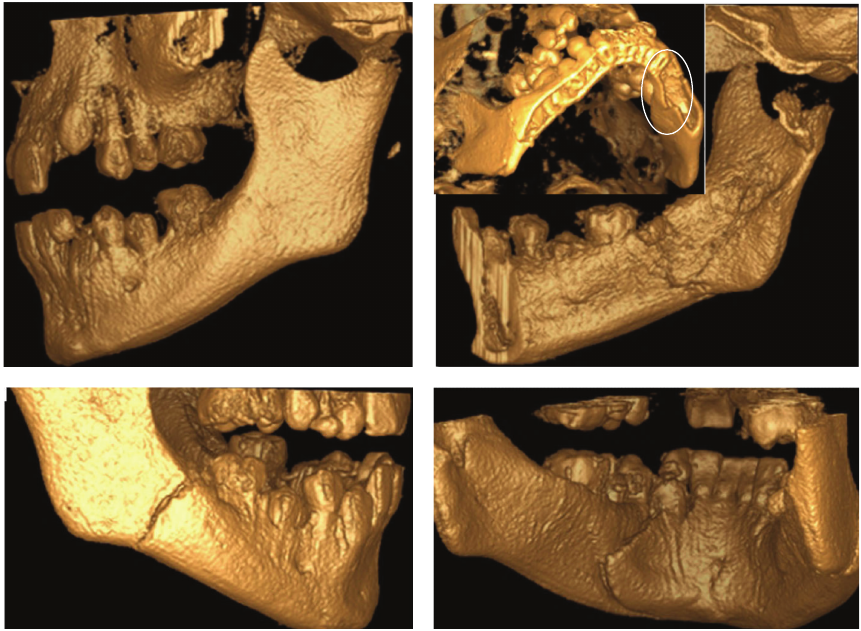
Figure 2: Cone beam CT views showing the fractures in the mandibular